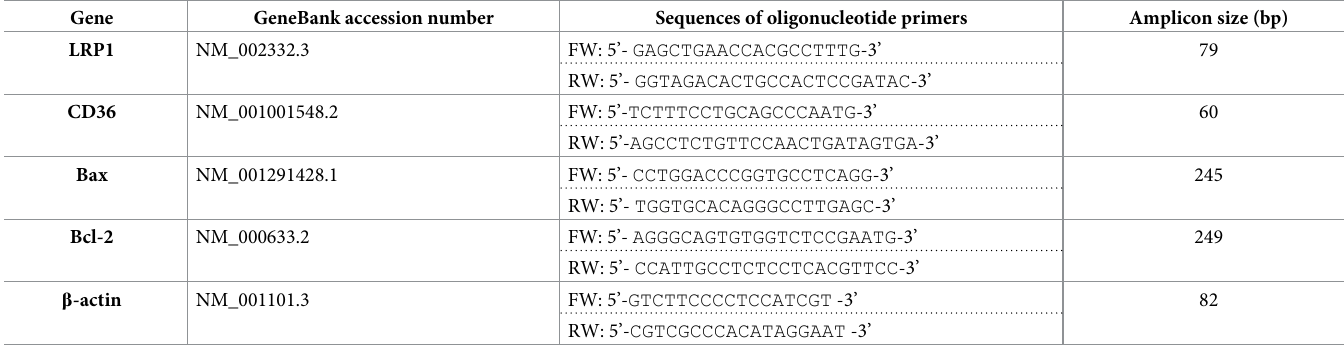
Table 1. Primers used for real-time PCR analysis.